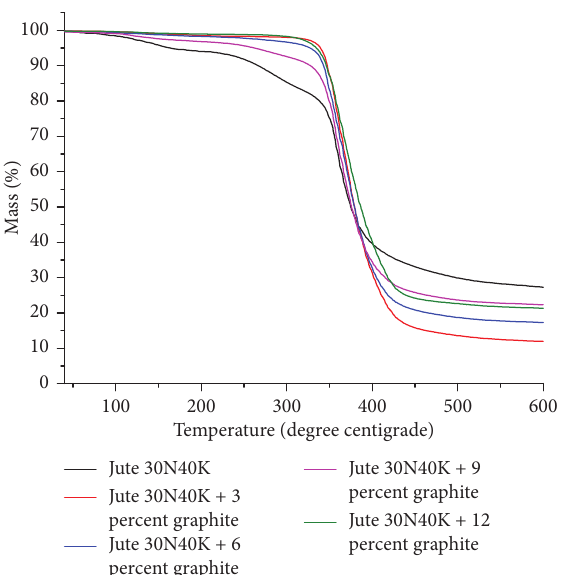
Figure 8: TGA curves of chemically treated used jute fiber with different weight ratios of graphite